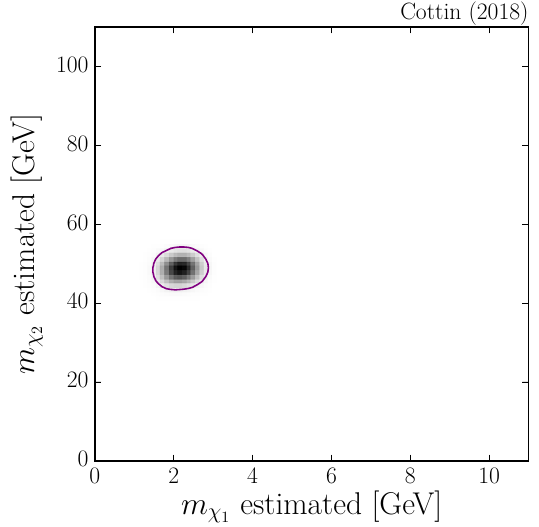
Figure 4 . Two-dimensional estimator map generated for the truth values ( m (cid:31) 95% of the points lie inside the purple contour.